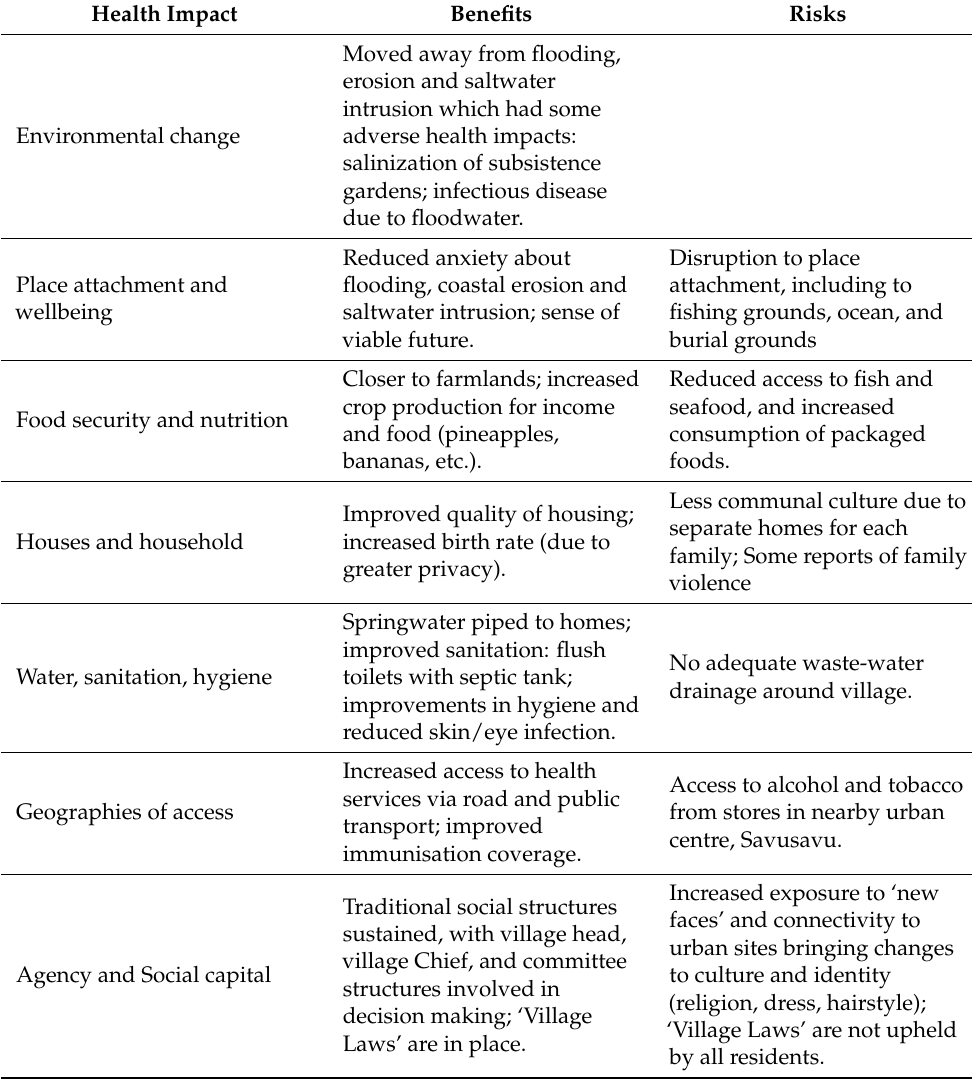
Table 1. Summary of health impacts of planned relocation, reported by